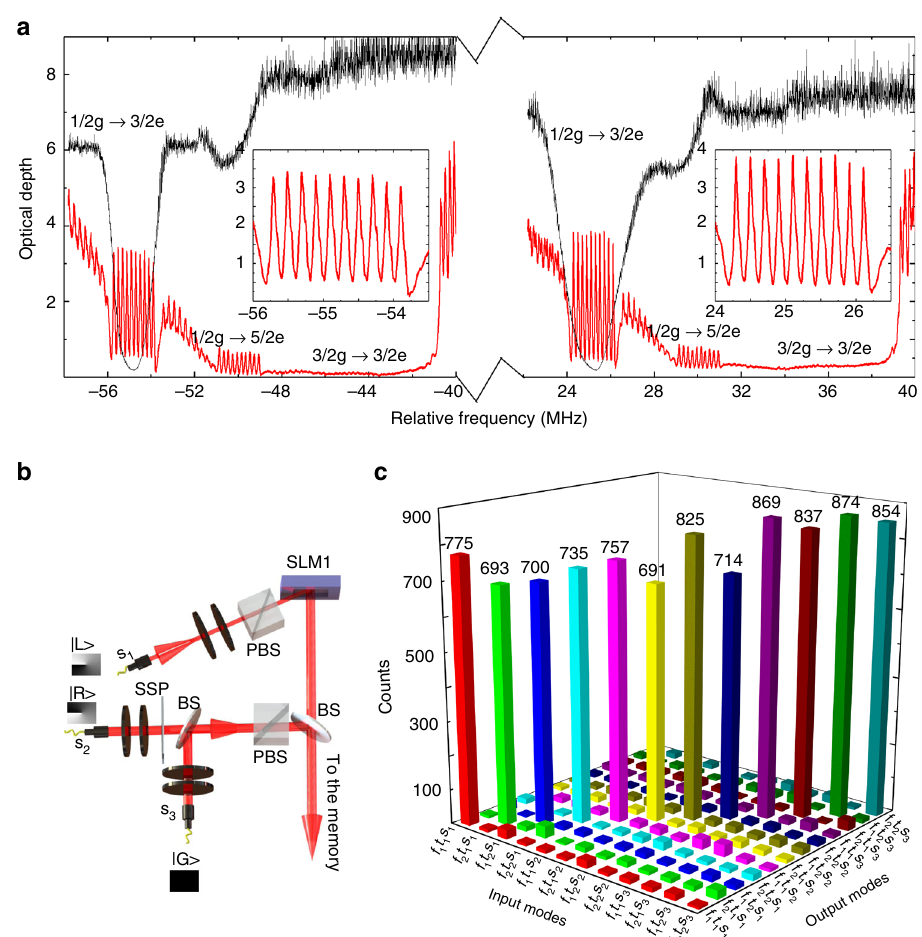
Fig. 3 Multiplexed spin-wave storage in three degrees of freedom at the single-photon level. a The double AFC structure (red) in the MC and the double fi lter structure (black) in the FC. b Three independent spatial modes carrying different OAM states are employed for spatial multiplexing. The spatial mode s 〉 state in SLM1. The spatial mode s 〉 state in a spiral phase plate (SSP); the spatial mode s 1 is converted into |L 2 is converted into |R 3 is a Gaussian mode which is used as |G 〉 state. They are combined by two pellicle beam splitters (BS). c A demonstration of temporal, spectral and spatial multiplexed storage for single-photon level